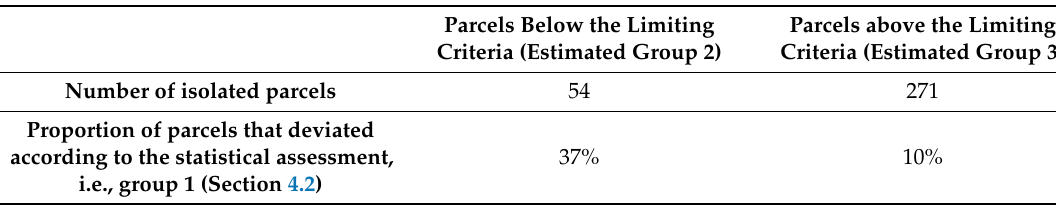
Table 6. Application of the limits derived from the model on the samples of isolated parcels and the distribution of group